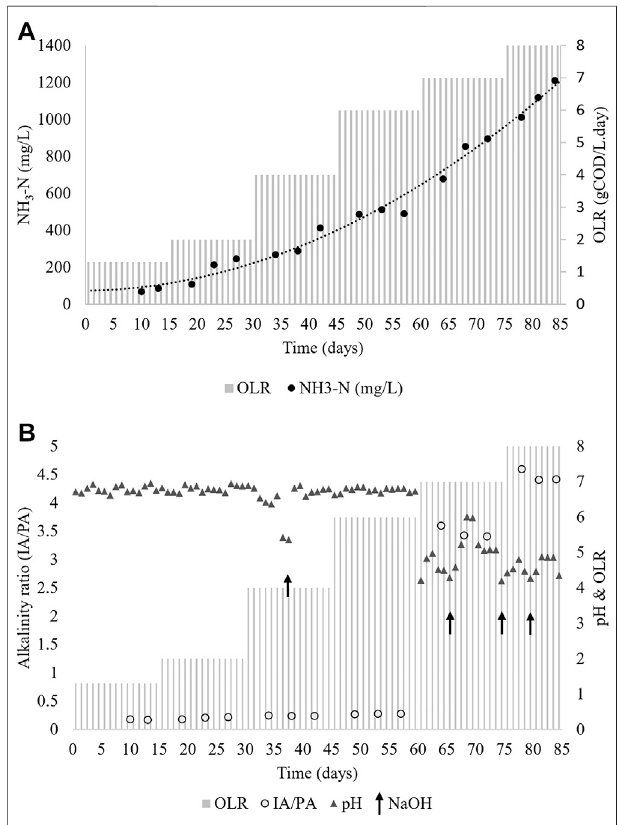
FIGURE 5 | CSTR digester stability. (A) Ammonia nitrogen (B) pH and alkalinity